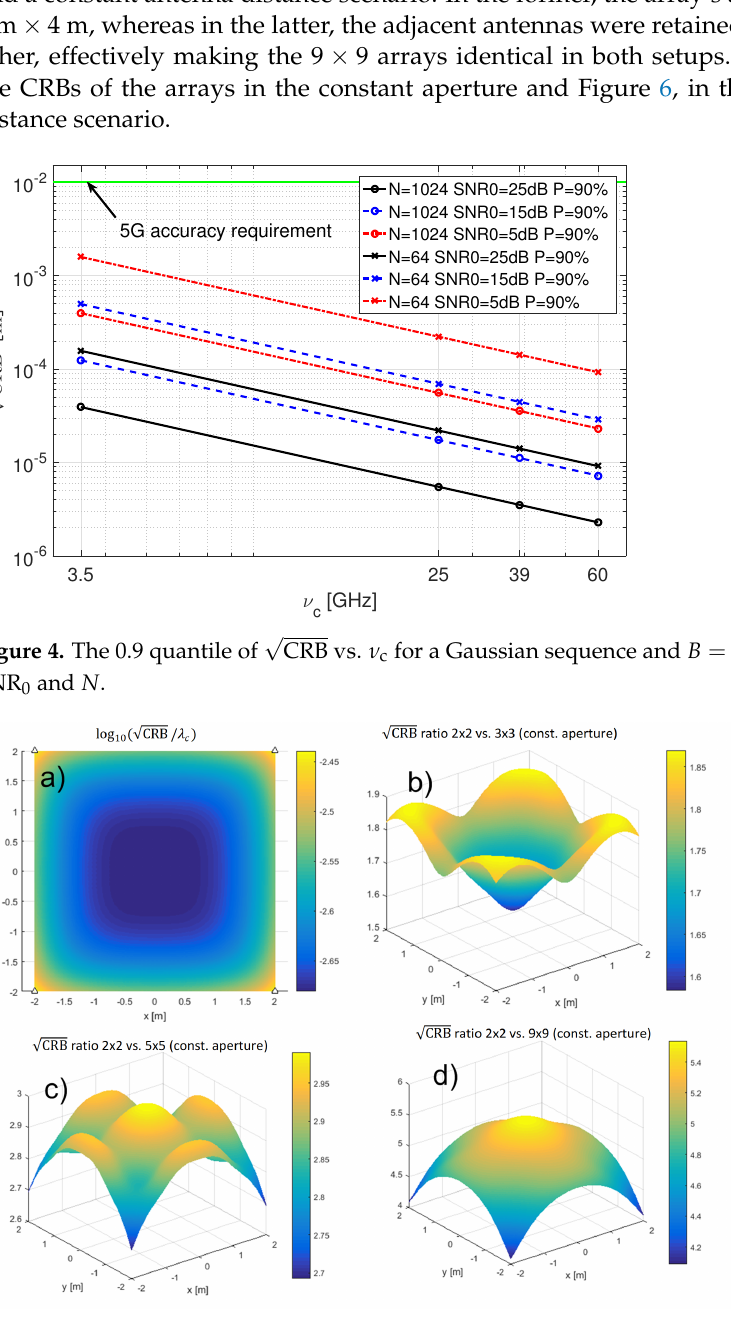
Figure 5. The CRBs for different array sizes in the constant aperture scenario. The square root of the CRB, normalized by the carrier wavelength, for the 2 × 2 array is shown in ( a ). The ratios of 2 × 2 on one hand and 3 × 3, 5 × 5, and 9 × 9 on the other are shown in ( b ), ( c ), and ( d ),